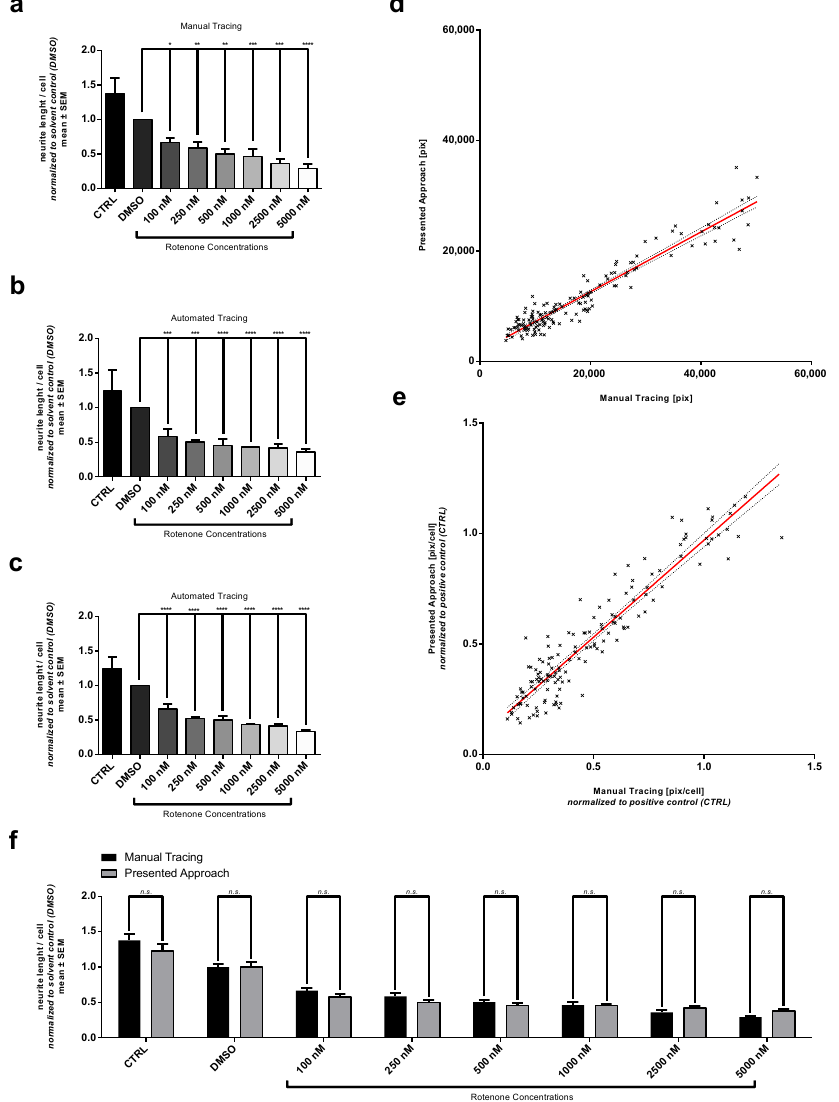
Figure 3. Comparison of results from automated and manual analysis. ( a ) Neurotoxic effect of Rotenone on the neurite network quantified with manual analysis: Mean neurite length per cell normalized to DMSO-treated solvent control (DMSO). ( b ) showing the neurotoxic effect of Rotenone on the neurite network quantified with automatically with our approach. Summed neurite length per image obtained from the output data was first normalized to cell count and afterwards normalized to DMSO. ( c ) showing results from automated analysis with two addi- tional experiments. Data are shown as mean ± SM. * Significantly different ( p < 0.05) between mean of solvent control (DMSO) and mean of according Rotenone treatment condition. Respec- tively ** with p < 0.01, *** with p < 0.001 and **** with p < 0.0001. ( d ) Linear regression per- formed on results of summed neurite per image quantified with automated and manual analysis. ( y = 0.5410 · x + 1792; R 2 = 0.9077) ( e ) Linear regression performed on results of neurite length nor- malized to cell count and afterwards to positive control (CTRL) ( y = 0.8789 · x + 0.09191; R 2 = 0.8841). ( f ) Mean values from automated analysis compared to mean values obtained from manual analysis. ( n.s. with p >